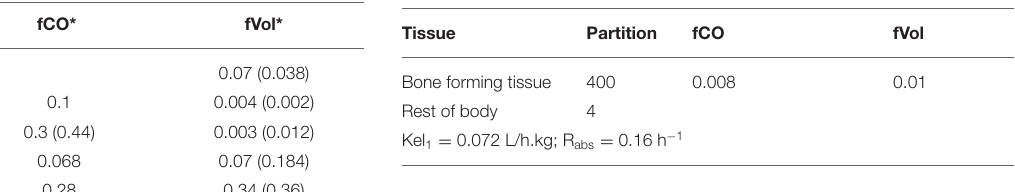
TABLE 2 | Parameter values for calves 100–200kg and steers > 200kg derived from literature.